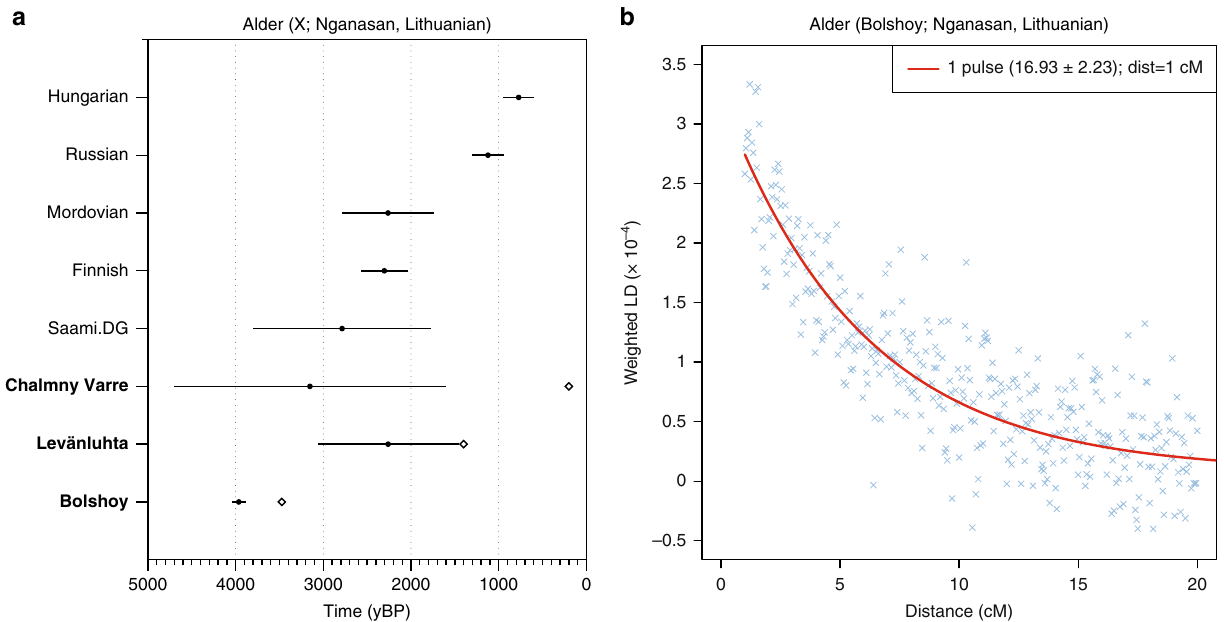
Fig. 5 Dating the introduction of Siberian ancestry using ALDER. a ALDER-inferred admixture dates ( fi lled circles) for different populations, using Nganasan and Lithuanian as sources. Available dates for ancient populations are shown in white diamonds. Error bars represent one standard error provided by ALDER and include the uncertainty surrounding the dating of ancient population samples, calculated using standard propagation. Populations containing individuals from this study are shown in bold. b LD decay curve for Bolshoy, using Nganasan and EHG as sources. The fi tted trendline considers a minimum distance of 1 cM. A full set of LD decay plots can be found in Supplementary Figure 5. Source data are provided as a Source Data fi